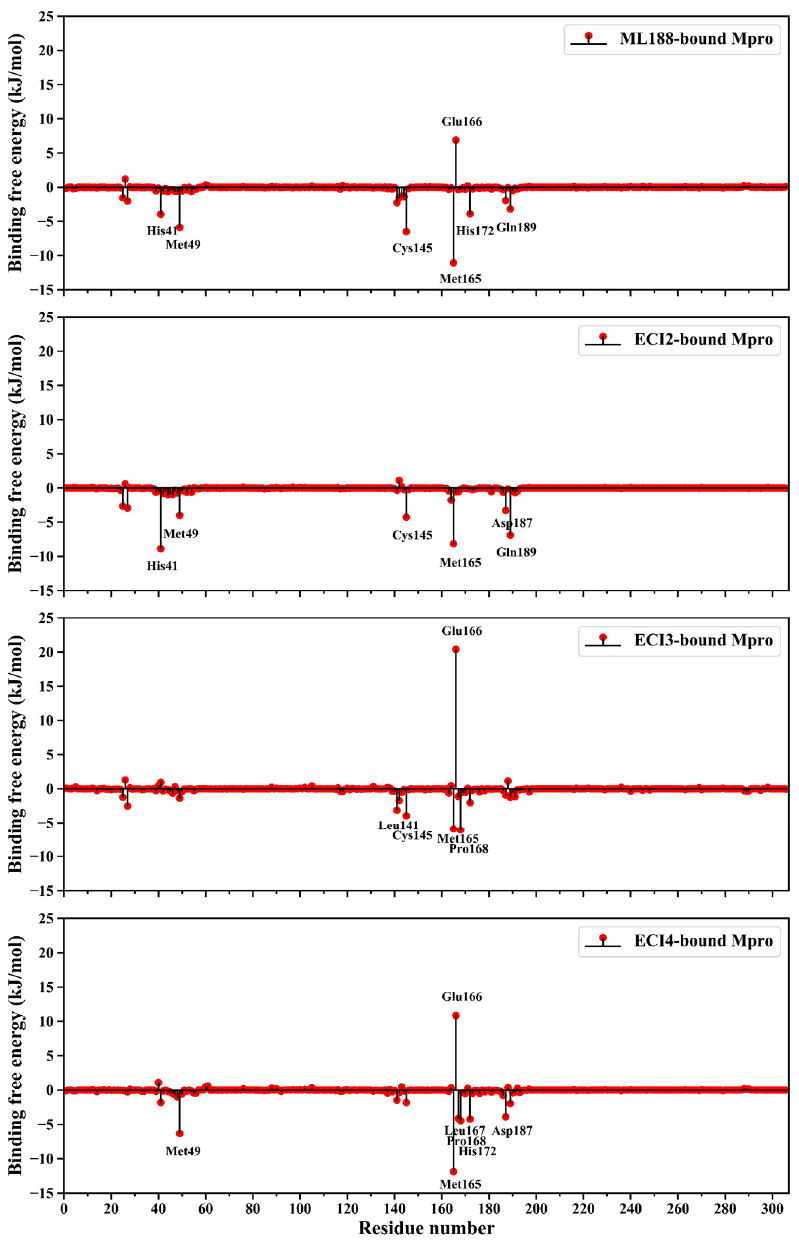
Figure 7. Per-residue binding free energy (BFE) decompositions of ML188-, ECI2-, ECI3-, and ECI4-bound Mpro. Residues with BFE values lower than − 3.0 kJ/mol (primary positive contributing residues (PPCRs)) or greater than 3.0 kJ/mol (primary negative contributing residues (PNCRs)) are labeled.